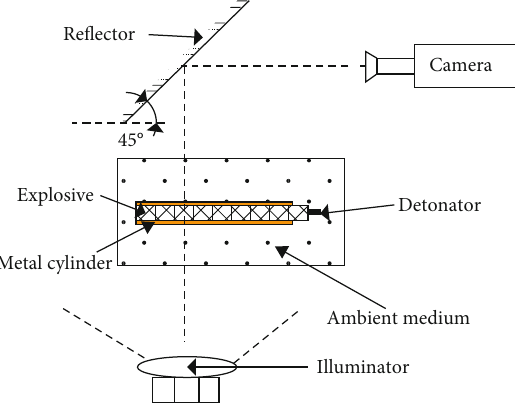
Figure 4: The whole experimental layout of explosively loaded metal cylinder test.